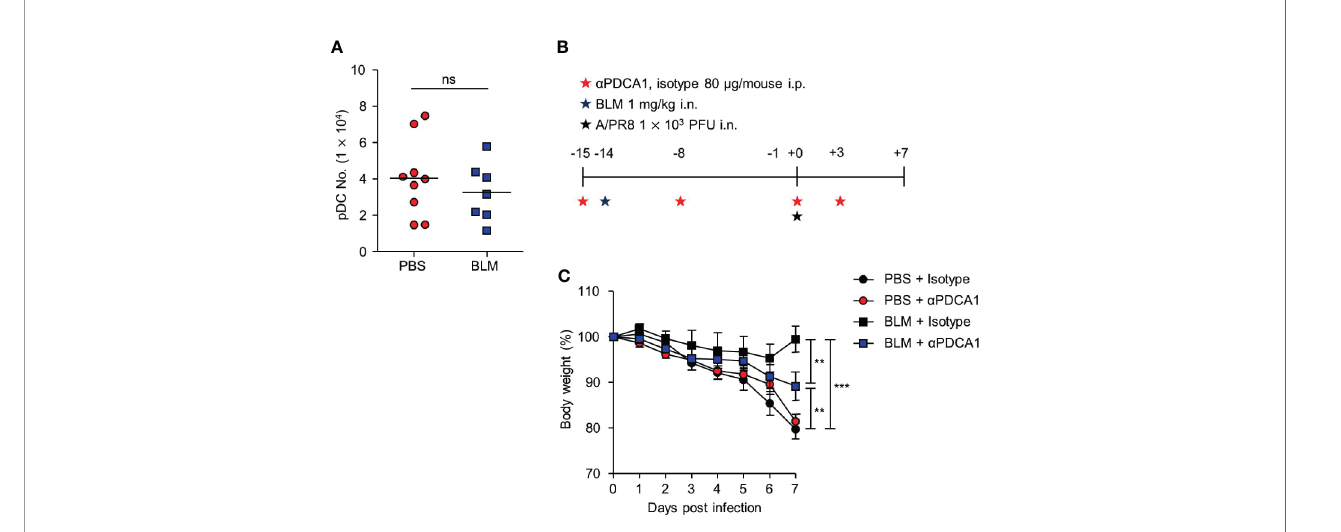
FIGURE 6 | pDCs contribute an antiviral effect after BLM-induced acute lung injury. Mice were sacri fi ced 14 days after BLM treatment. (A) Analysis of the number of pDCs in the lung by FACS ( ● , n = 9; ■ , n = 7). (B) a PDCA-1 and isotype were administered intraperitoneally (i.p.) to mice following the scheme; mice were then infected with a sub-lethal virus dose intranasally (i.n.). (C) Body weight was monitored for 7 days ( ● , n = 5; ● , n = 6; ■ , n = 4, ■ ; n = 5). Data are expressed as mean ±SEM and representative of 2 independent experiments. Results in (A) were analyzed statistically using t-tests and in (B) using Two-way ANOVA (** p < 0.01, *** p < 0.001). ns, not signi fi cant.